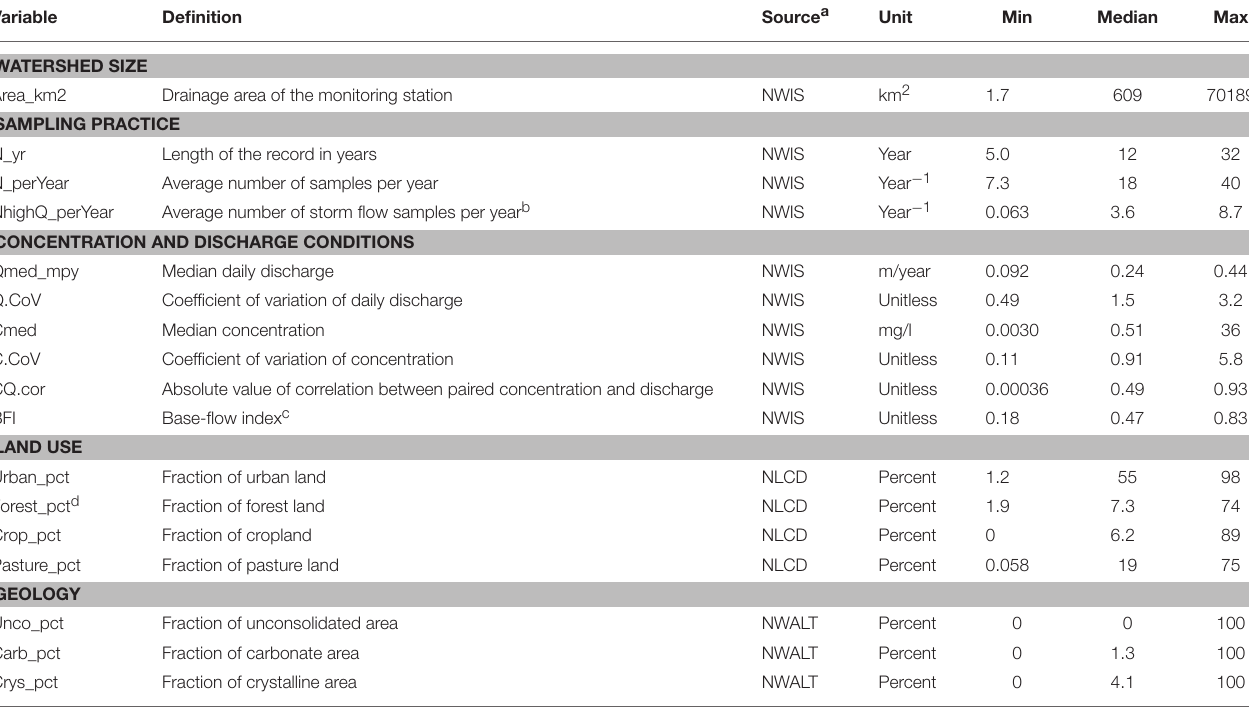
TABLE 1 | List of explanatory variables and their definitions, units, and data sources.